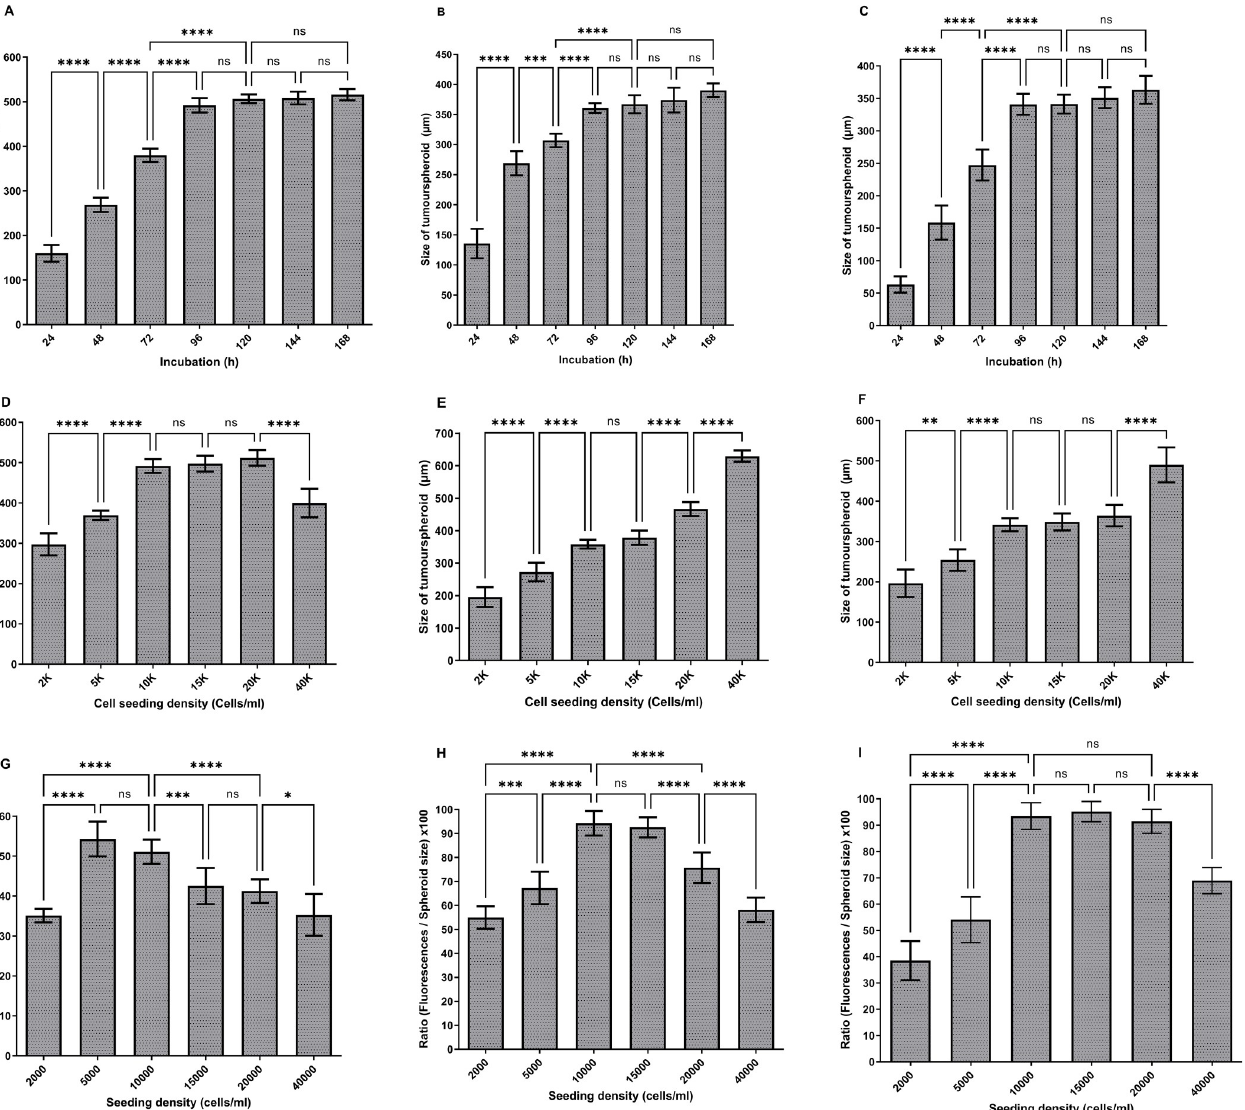
Fig 3. Development of U-251 MG human glioblastoma astrocytoma 3D in vitro cell culture models using low attachment plate method. A) U-251 MG, B) U-87 MG, C) A-172 tumourspheres growth (diameter in μ m) analysis during different incubations. D) U-251 MG E) U-87 MG, F) A-172 growth analysis after 96h incubation (diameter in μ m) at increasing seeding density. The mean of the diameter was used to plot the values on columns and analysed using one-way ANOVA with tukey’s post-test (ns, not significant (p > 0.05); � p < 0.05; �� p < 0.01, ��� p < 0.001; ���� p < 0.0001). G) U-251 MG H) U-87 MG, I) A-172 spheroid cell health analysed and a higher ratio indicates healthier spheroids. The mean of the [(fluorescence / spheroid size) x 100] was used to plot the values on columns and analysed using one-way ANOVA with tukey’s post-test (ns, not significant (p > 0.05); � p < 0.05; �� p < 0.01, ��� p < 0.001; ���� p < 0.0001).